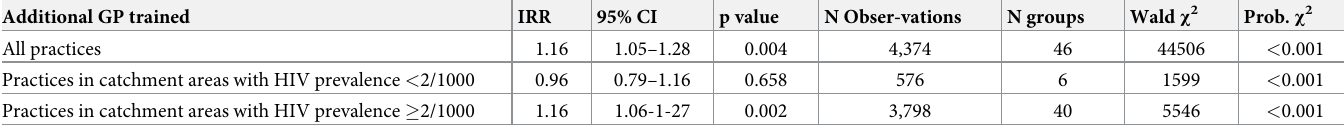
Table 2. Effect of SHIP training on HIV testing rates. The unit of observation is practice-month. All regressions control for practice and month fixed effects. 95% CIs are based on robust standard errors, which were adjusted for clustering on practice. IRR = HIV testing incidence rate ratio, CI = confidence interval. Additional GP